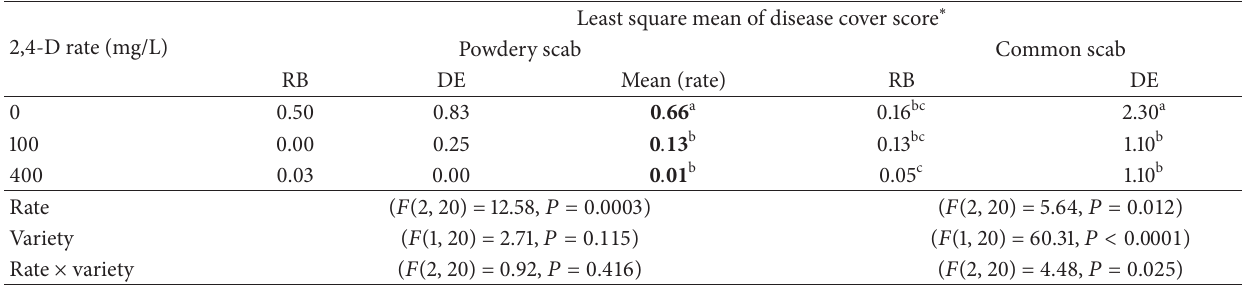
Table 1: Glasshouse trial: effect of foliar applications of 100 or 400 mg/L 2,4-D on plants of potato varieties Russet Burbank (RB) and Desiree (DE) on powdery scab and common scab severity.